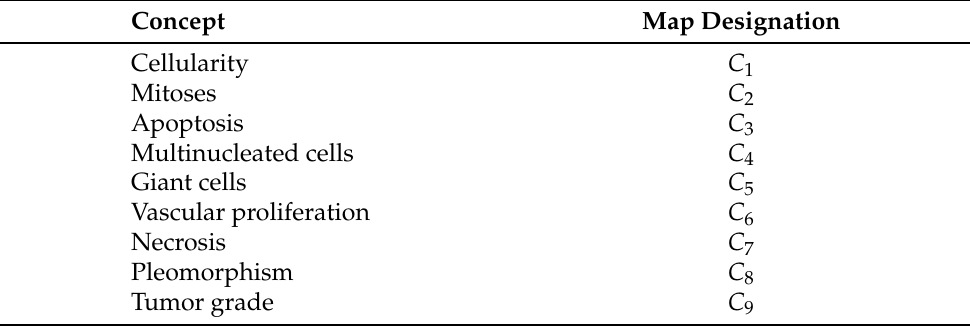
Table 6. Concepts in the fuzzy cognitive map determining the grade of brain tumor.